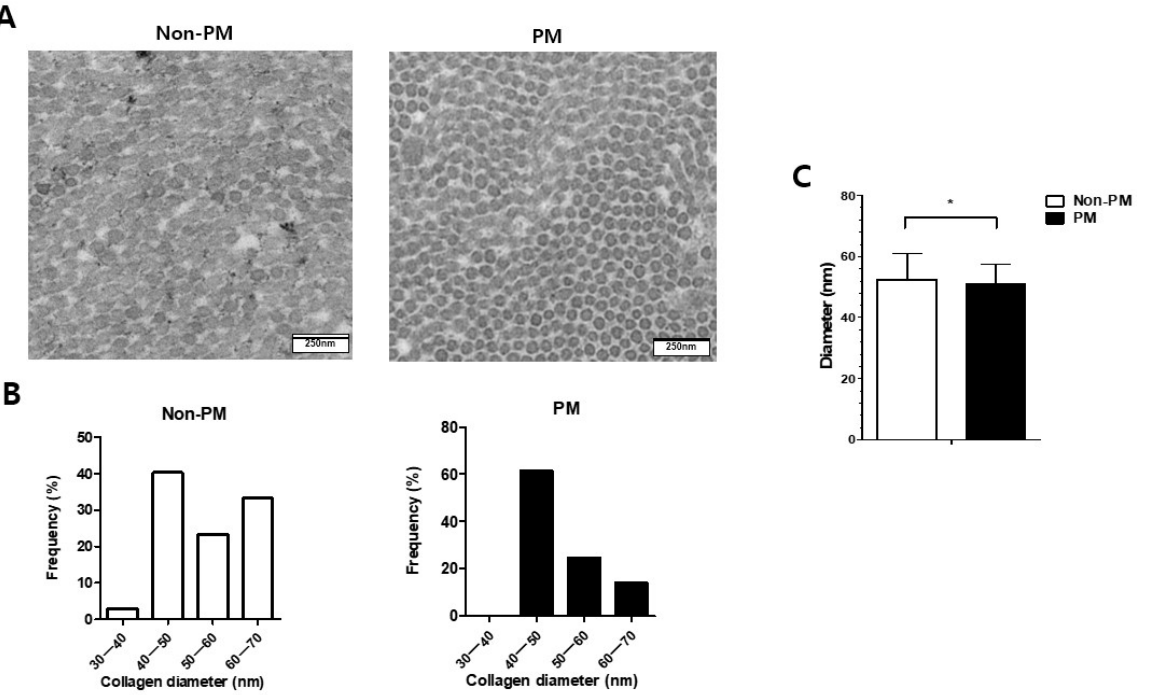
Figure 3. ( A ) Transmission electron microscopy (TEM) images of the collagen fibrils, ( B ) frequency of collagen fibril diameters, and ( C ) mean diameter of collagen fibrils in the Achilles tendons of control (non-PM) and PM-exposed rats 6 weeks post-operation. * p < 0.05.